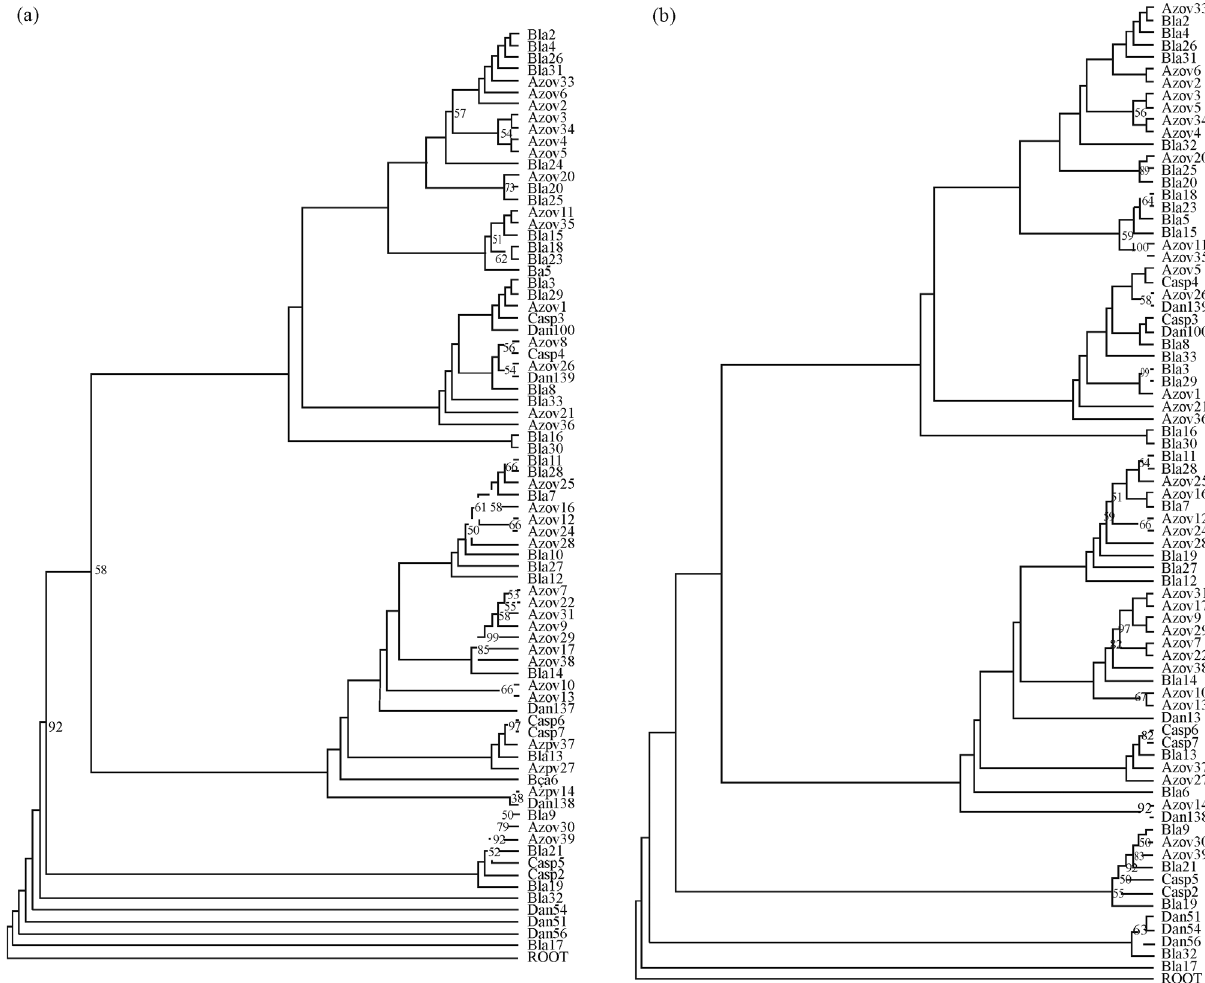
Figure 3 - Molecular phylogenetic trees inferred by partial D-loop sequences analysis by NJ (a) and ML (b) in A. stellatus constructed using Tamura3 pa- rameter plus G model with 1000 bootstrap iterations. ROOT- indicates the outgroup species A. baerii (NC_017603). The numbers represent the confi- dence bootstrap values higher than 50. Bla= Black Sea; Casp = Caspian Sea; Azov = Azov